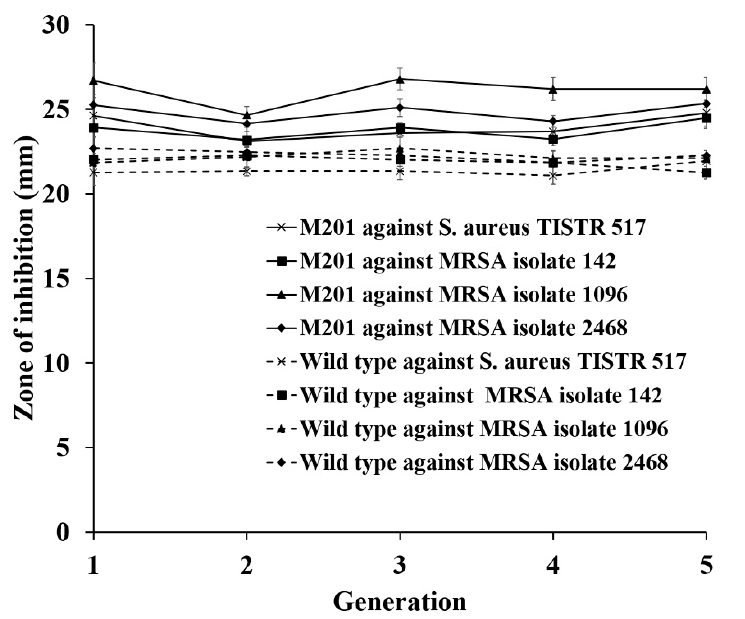
Figure 5. Strain stability between the wild-type strain of Brevibacillus sp. SPR-20 and its mutant strain (M201) for five generations. Agar well diffusion was performed against a number of indicator pathogens. The results for the inhibition zone are represented as mean ± SD ( n = 3).